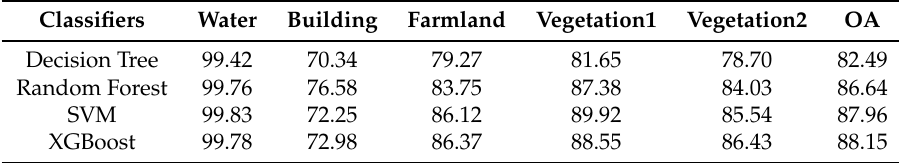
Table 3. Classification accuracies on data set B: by classes and overall accuracy (%).